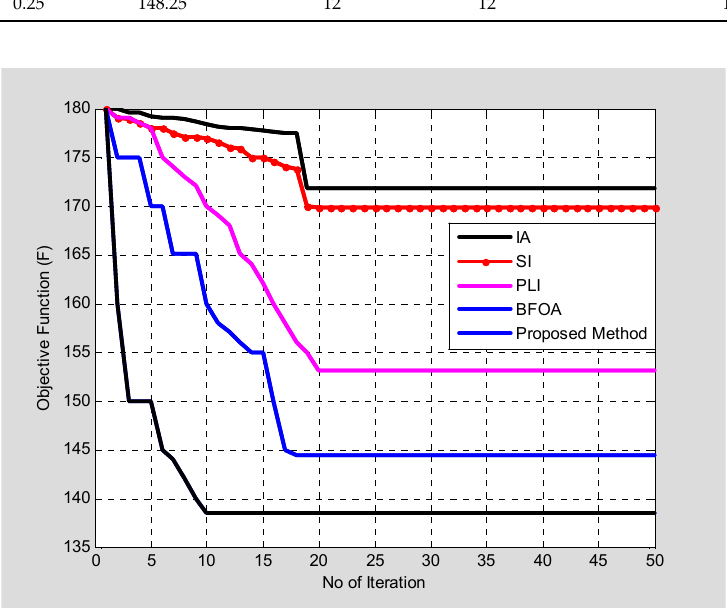
Table 4. Optimal parameter setting of CSA for 33-bus system.